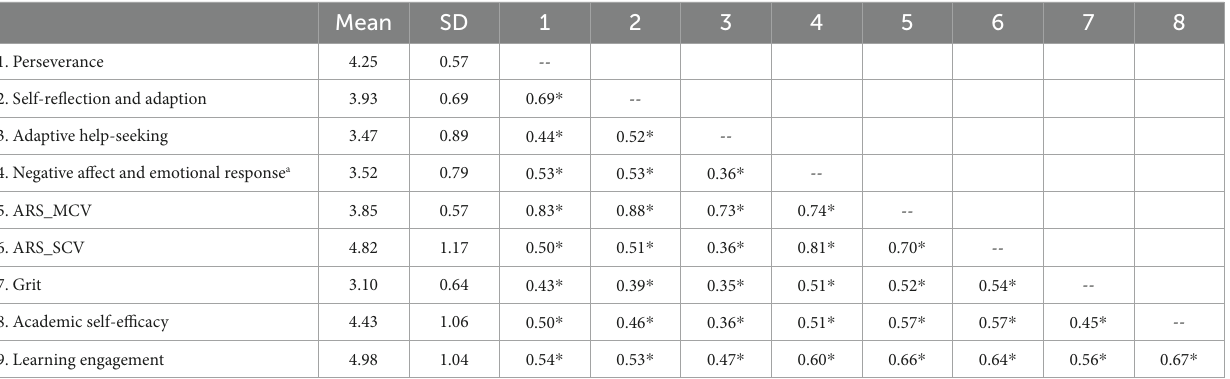
TABLE 7 Pearson correlation coefficients among